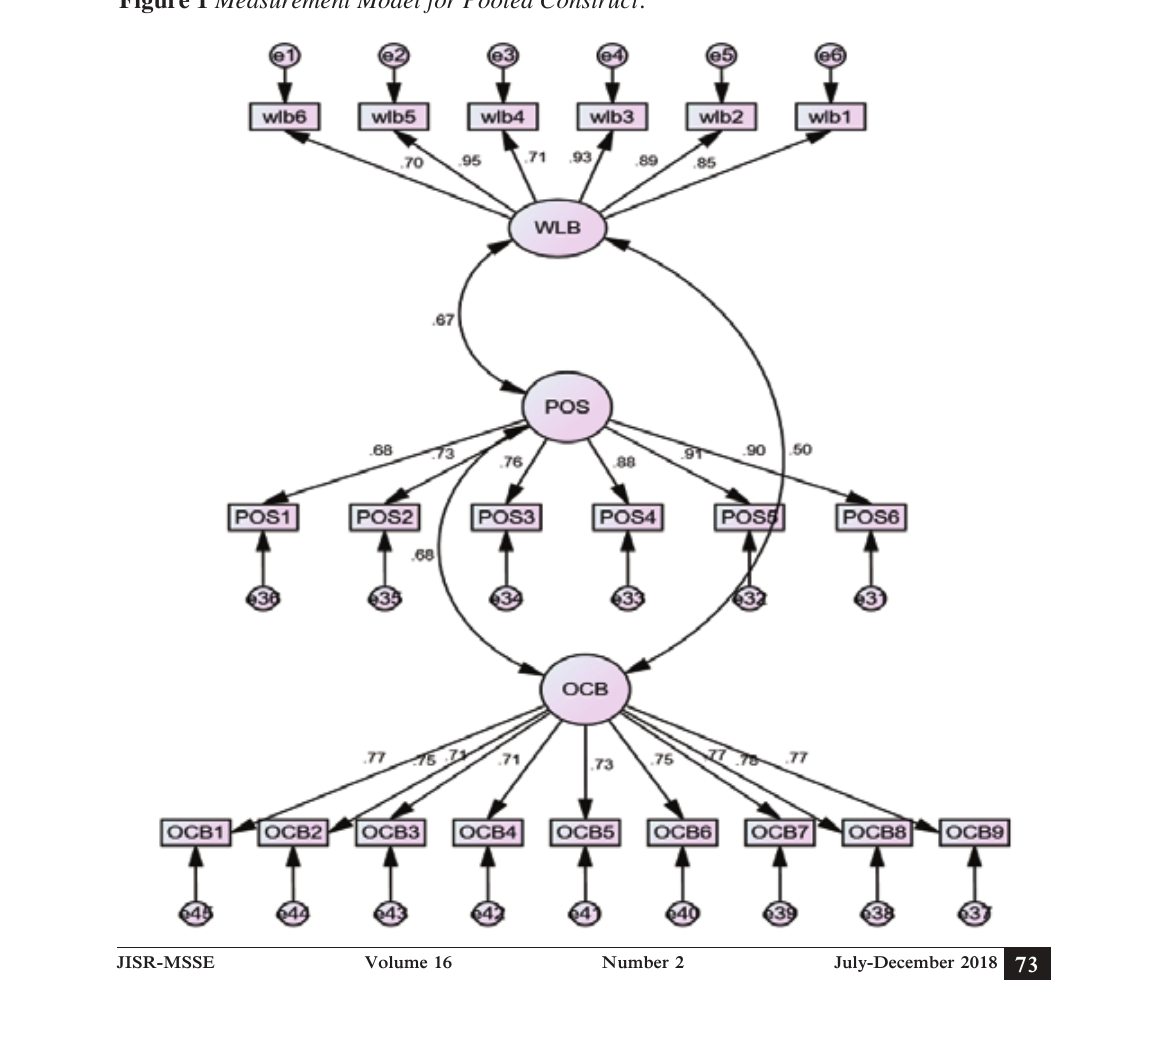
Figure 1 Measurement Model for Pooled